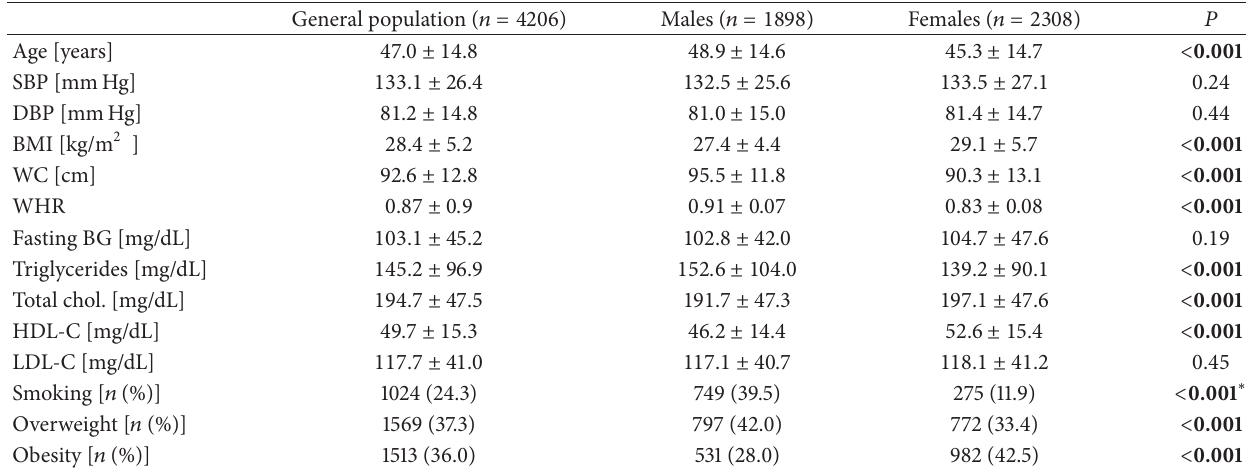
Table 1: The demographic characteristics of the Turkish adult population.